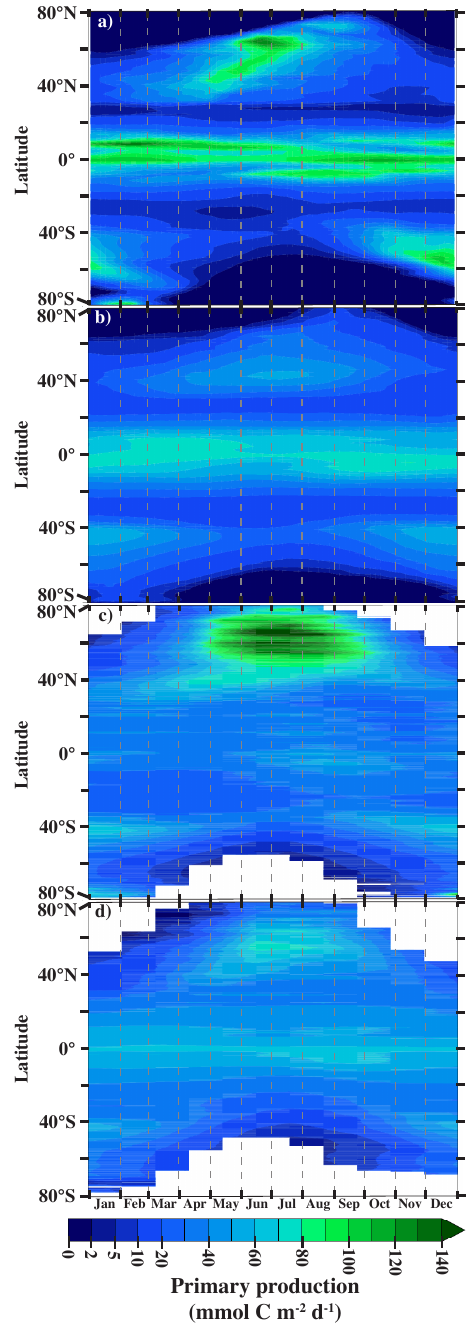
Fig. 18. Hovm¨oller diagrams of the zonally averaged sea- sonal changes in integrated primary production as simulated by the (a) new and (b) old models and from (c) Behrenfeld and Falkowski’s (1997) vertically generalised production model (VGPM) and (d) Westberry et al.’s (2008) carbon-based productiv- ity model